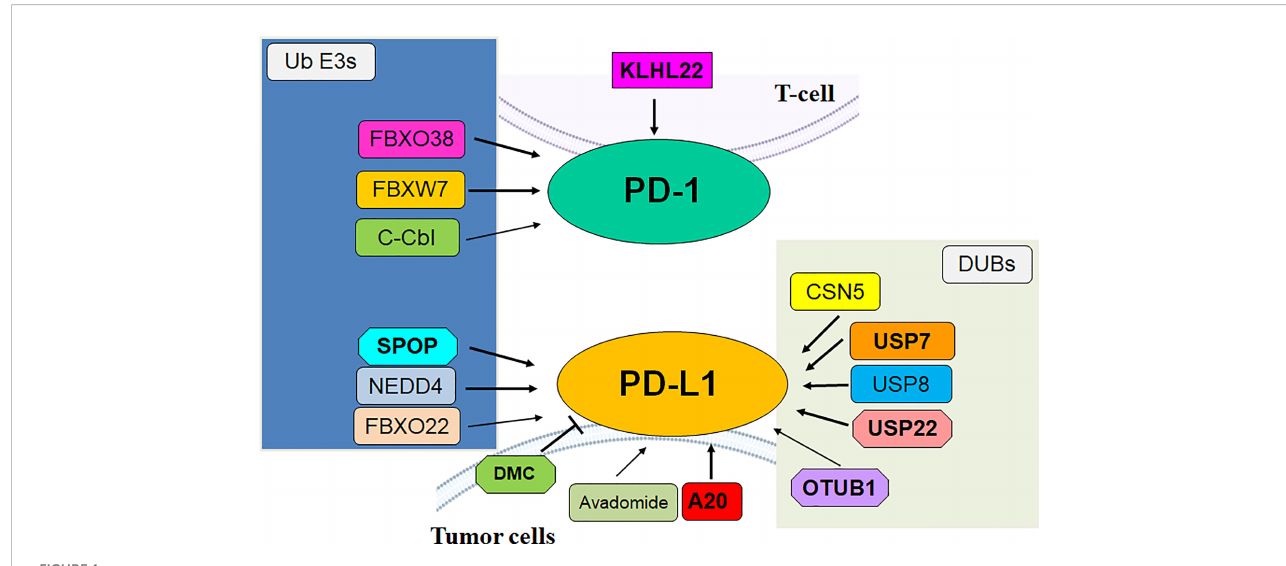
FIGURE 1 The role of E3 ubiquitin ligases and DUBs in regulation of PD-1/PD-L1 in cancer.